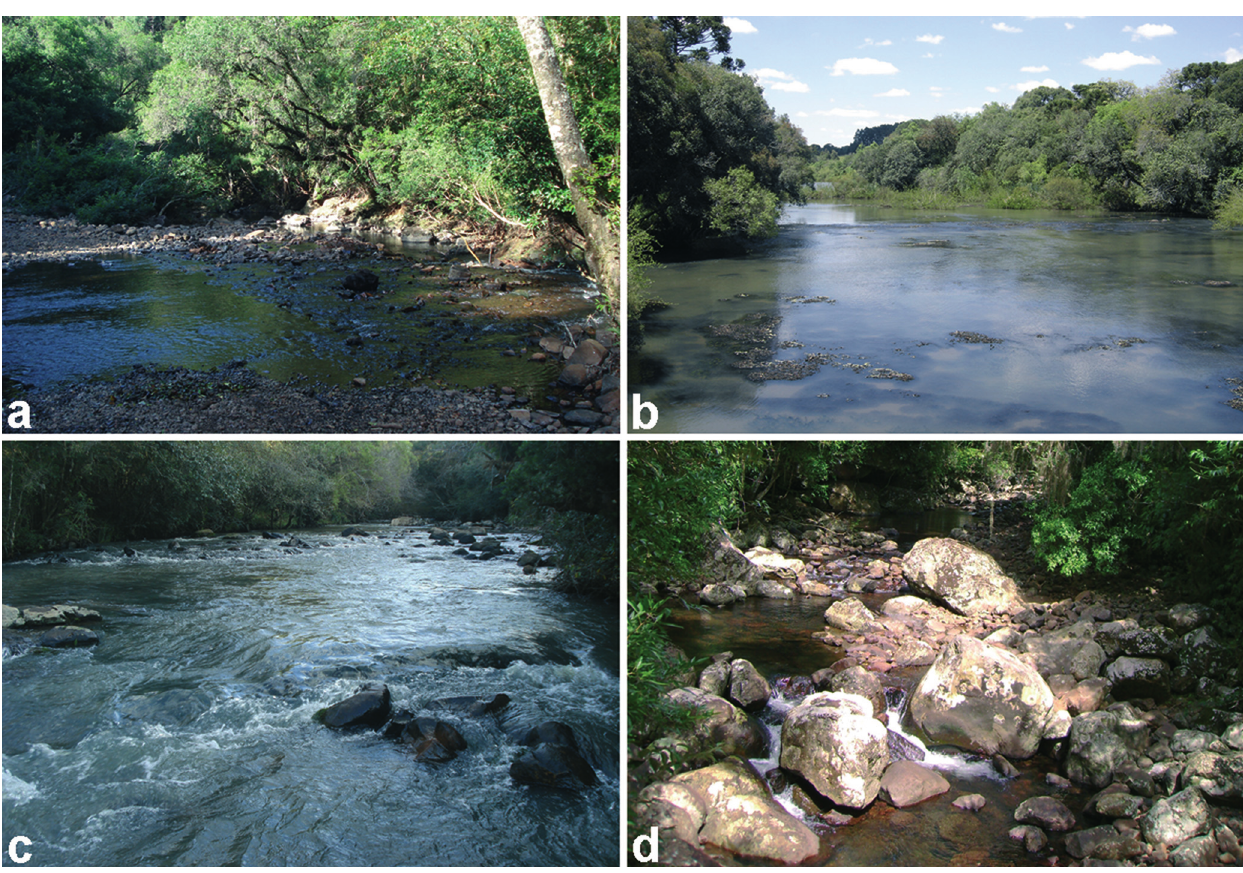
Fig. 9. Arroio Bagual, municipality of Bom Jesus, locality of collection of some type specimens of Trichomycterus balios ( a ). Type locality of T . diatropoporos : rio da Prata at Passo do Despraiado, municipality of Nova Prata ( b , photo by T. P. Carvalho). Type locality of T . poikilos : arroio Passo dos Buracos or Tipiaia on road BR-158, municipality of Júlio de Castilhos ( c ). Locality where most type specimens of T . brachykechenos (11 specimens) were collected: rio dos Sinos, municipality of Caraá ( d , photo by R. B. Dala-Corte). All localities from Rio Grande do Sul State,